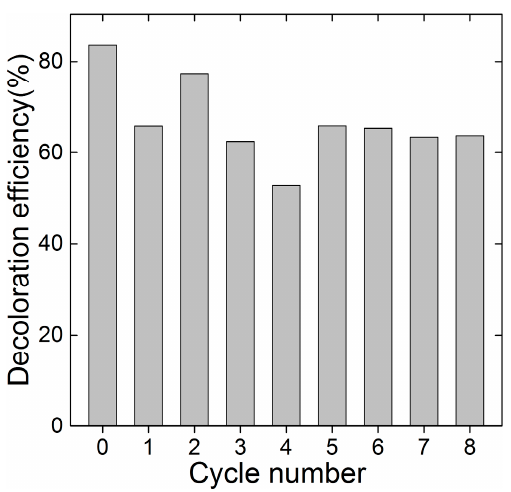
Figure 7. Recycle of FTCNCs after the decoloration of MB (methylene blue).